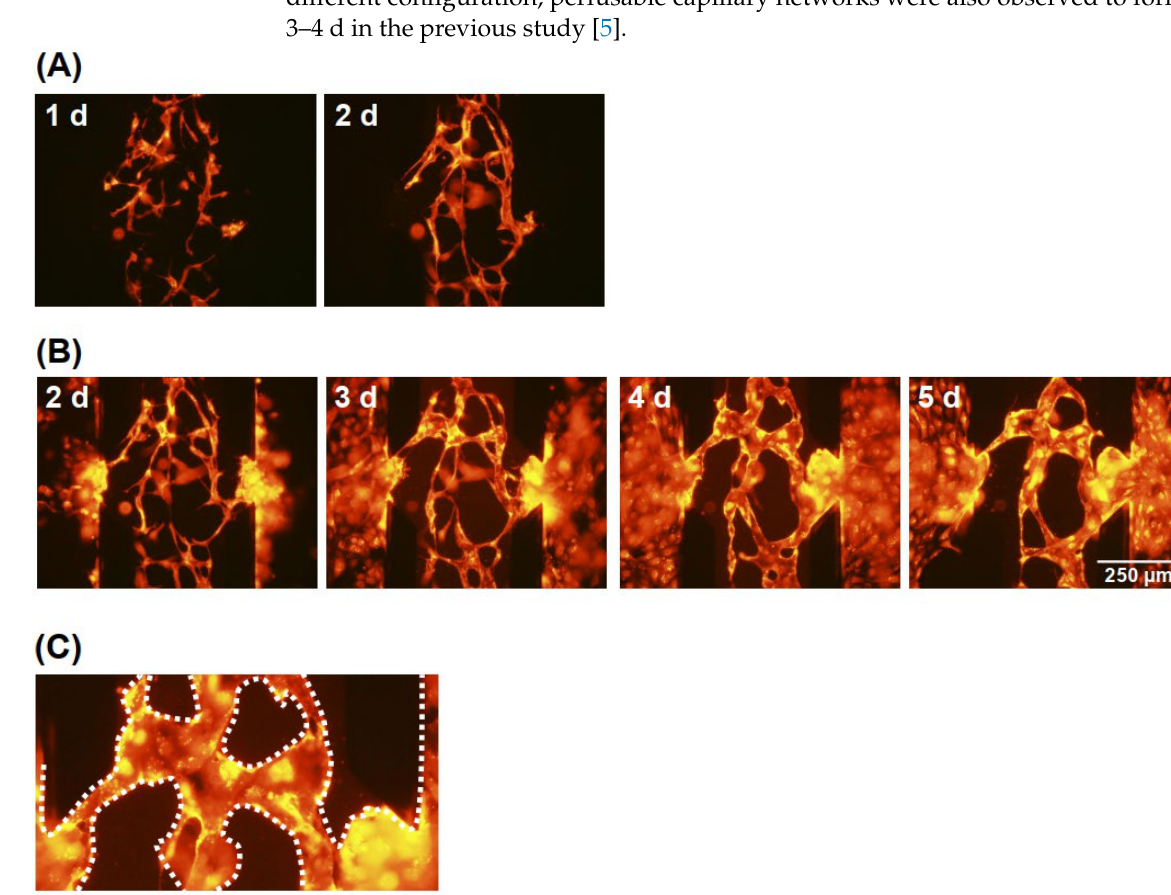
Figure 3. Fluorescence images of vascular vessel formation ( A ) before and ( B ) after preparation of the HUVECs monolayers. ( C ) Magnified image after 4 d. White dotted lines indicate the vessels.